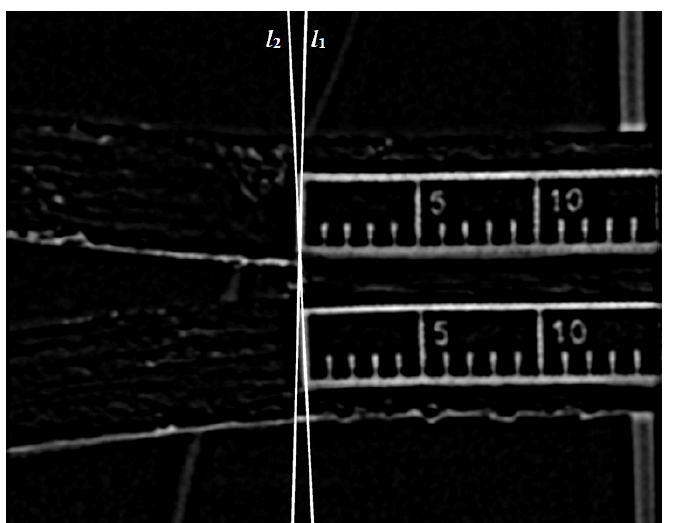
Figure 5: Image after applying the Difference of Gaussian filters and the extracted lines ( l 1 and l 2 ) that are used for measuring  o . Then, for the rows of the image between p 5 and p 6 , the midpoint of the edge at each row is computed. The midpoint is first extracted for the row of p 5 by (1) collecting all the pixels to the left and to the right of p 5 that can be reached from p 5 without dropping the pixel intensity bellow a given threshold (10% for all experiments), and (2) by averaging the position